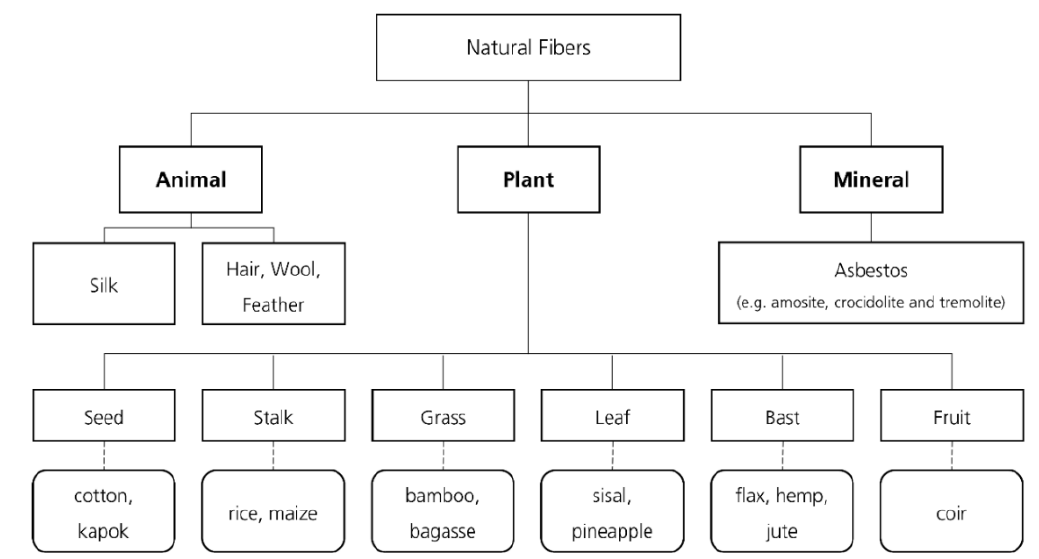
Figure 2. Classification of natural fibers according to Reference [47].